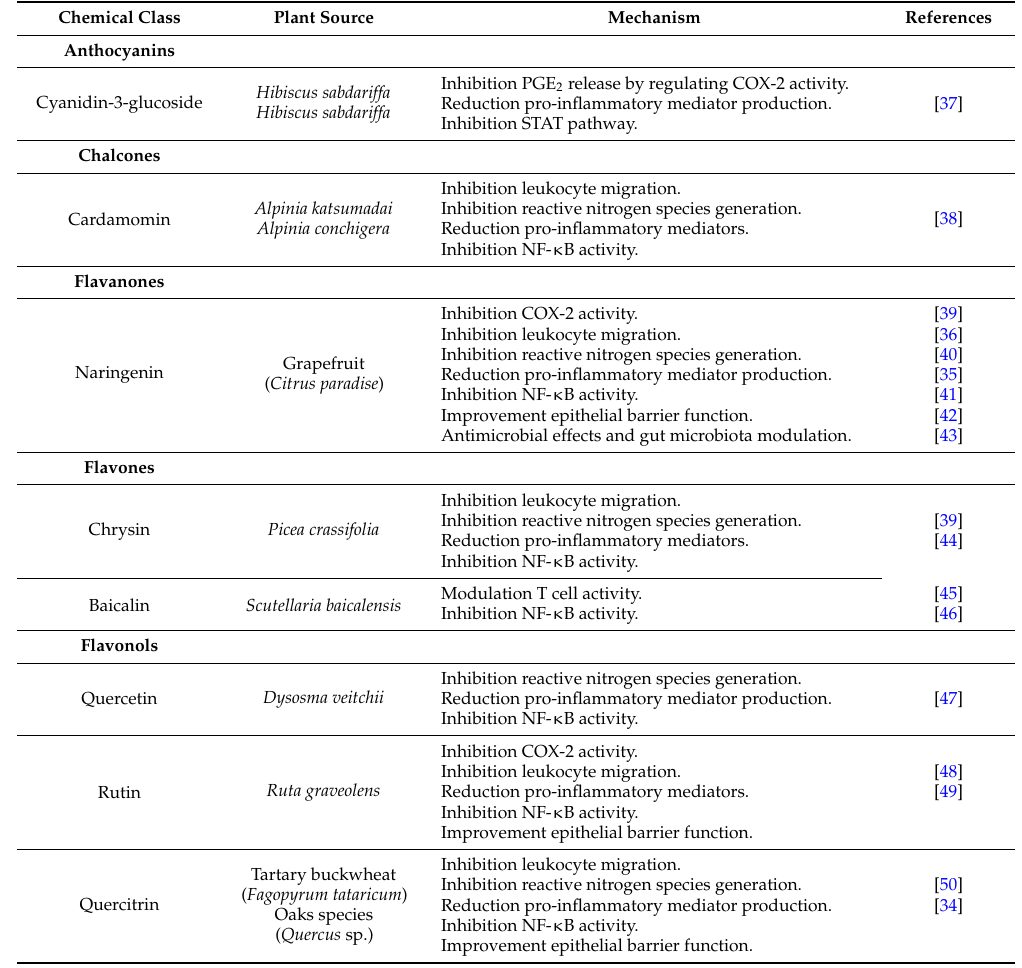
Table 1. Flavonoids’ intestinal anti-inflammatory